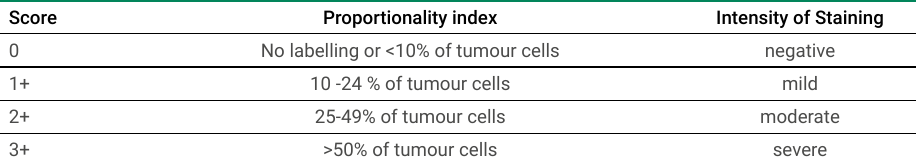
Table 1. Scoring criteria for evaluation of expression of p53 and Cyclin